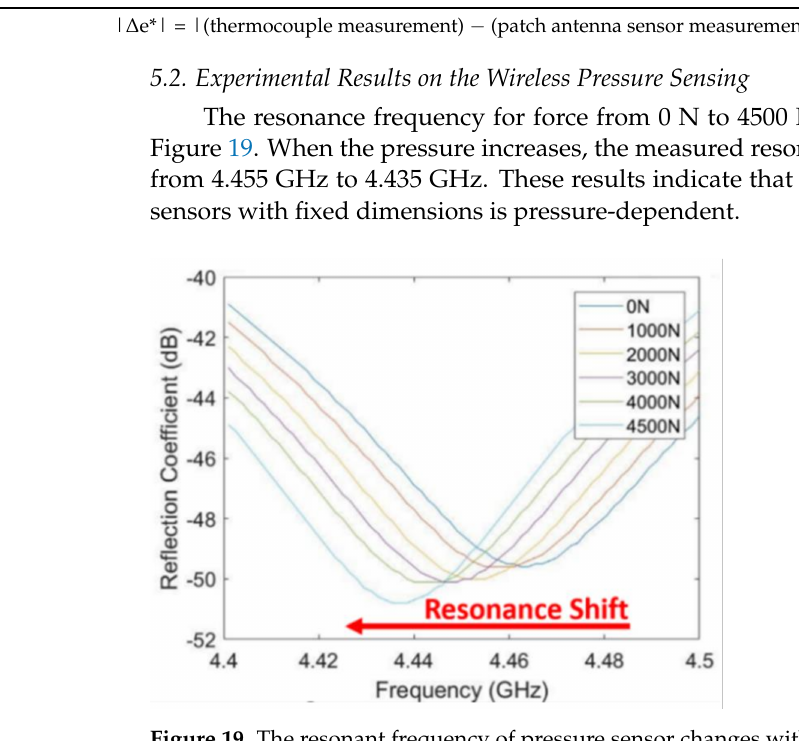
Figure 19. The resonant frequency of pressure sensor changes with varying